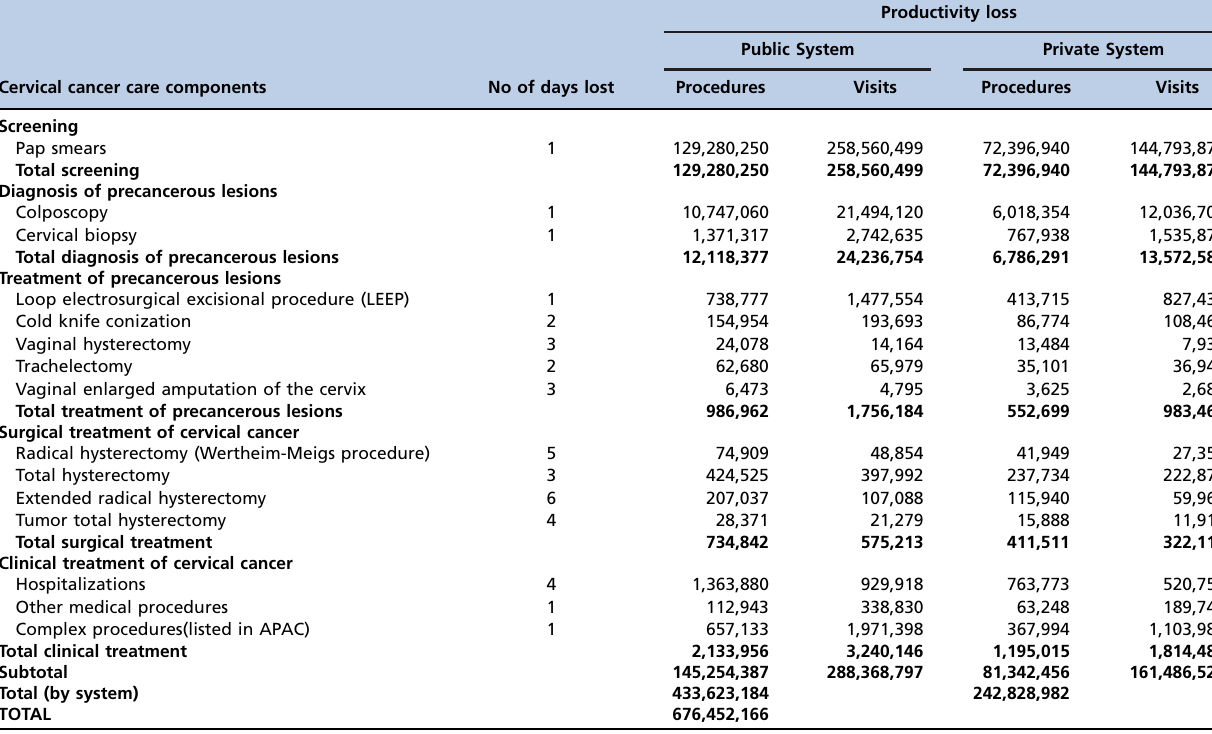
Table 3 - Estimates of indirect costs (productivity loss) associated with the screening, diagnosis and treatment of precancerous lesions and the diagnosis and treatment of cervical cancer in the public and private health systems in Brazil, in 2006 United States dollars.